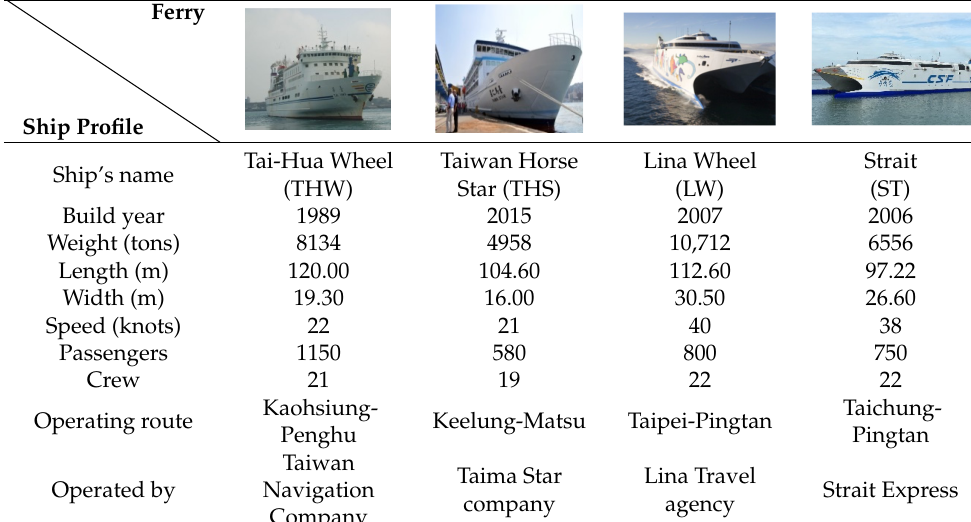
Figure 1. Ferry routes between Taiwan and archipelagic islands. Table 1. The ship profiles of main ferries in Taiwan.